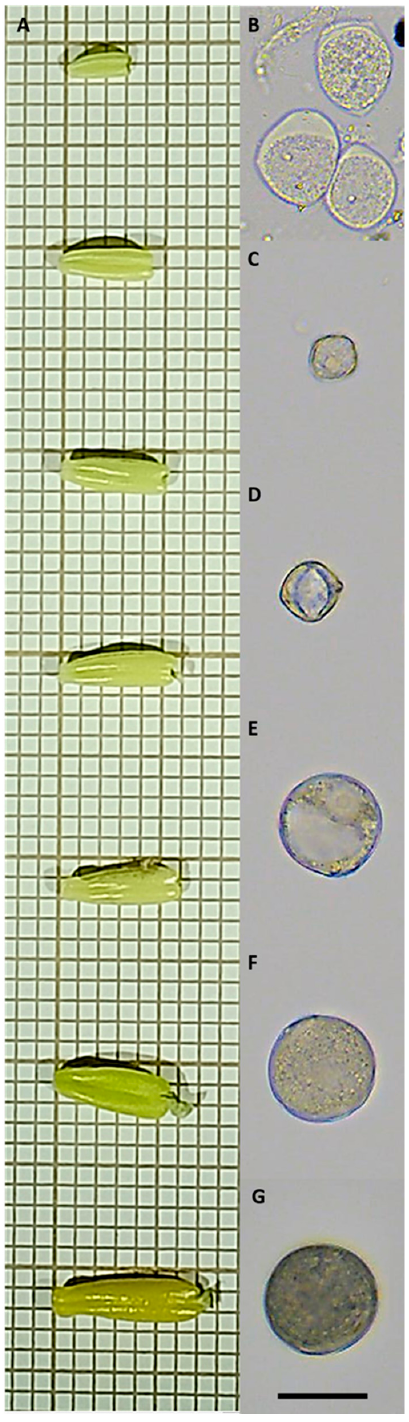
Figure 4 . Eggplant anthers at different stages of development ( A ). Different stages of development of the pollen, tetrad ( B ), young microspore ( C ), medium microspore ( D ), vacuolated microspore ( E ), young pollen ( F ) and mature pollen stages ( G ). These have been the stages chosen to define the classes used to train the prediction model algorithm. The predominant stage of pollen development that each contained within each anther inside approximately corresponds to the state indicated in the image to the right of each anther size. The squares in the left images measure 1 mm, while the bar in the images in the right part of the figure measure 20 µm.